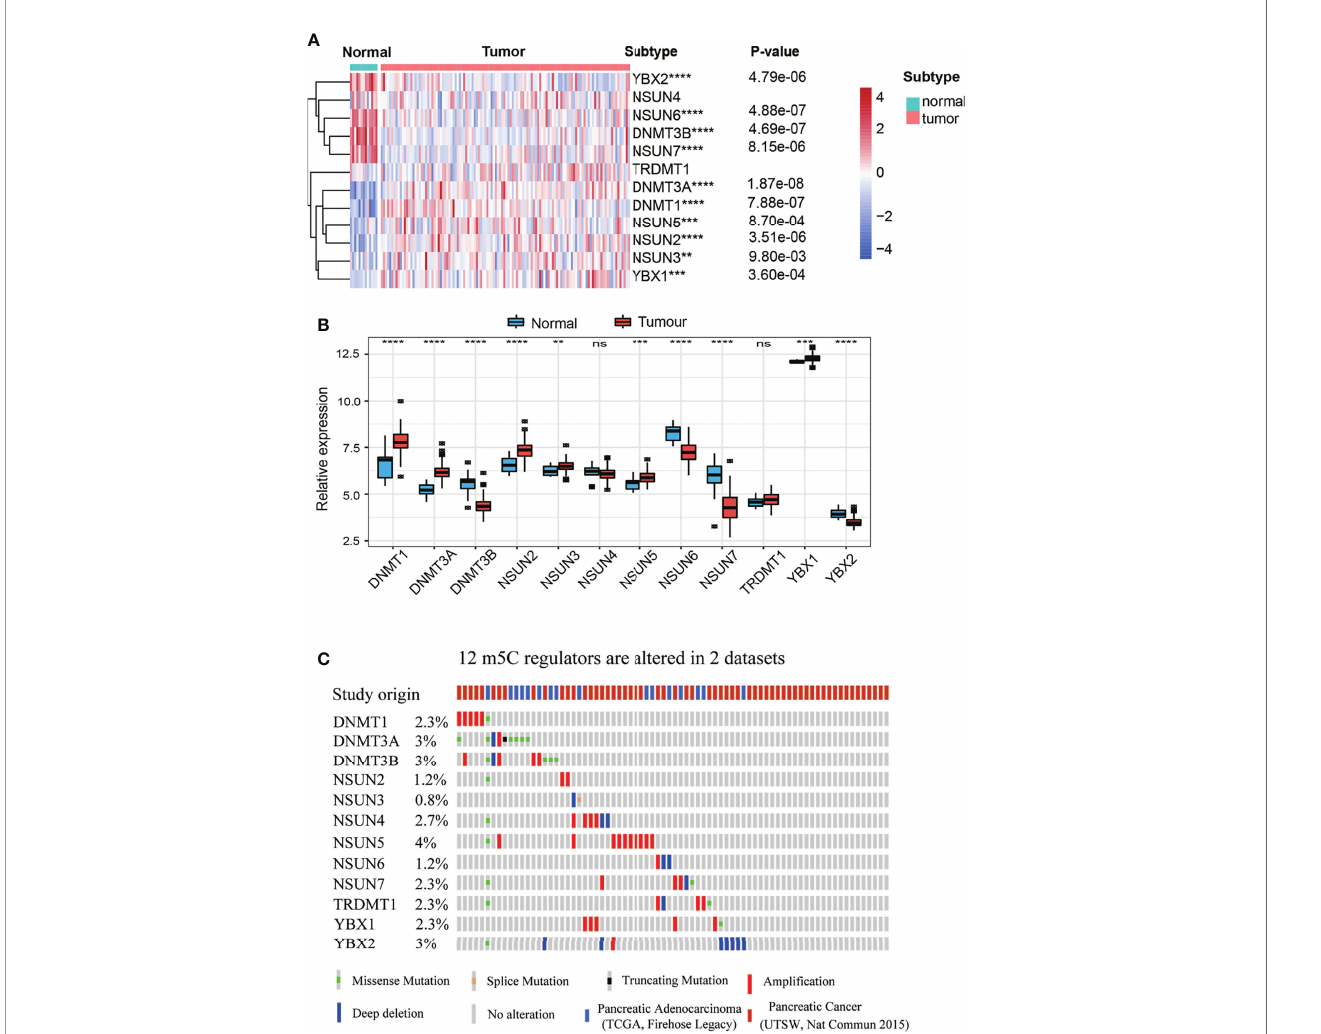
FIGURE 2 | Landscape of expression and genetic alterations of m 5 C regulators in PAAD. (A, B) The mRNA expression levels of 12 m 5 C regulators between normal and PAAD samples in the GSE61625 dataset. (C) Fifty-one of the 259 PAAD patients in 2 studies had genetic alterations of 12 m 5 C regulators in the cBioPortal database. ** represents p value < 0.01, *** represents p value < 0.001, **** represents p value < 0.0001, ns means "not statistically signi fi